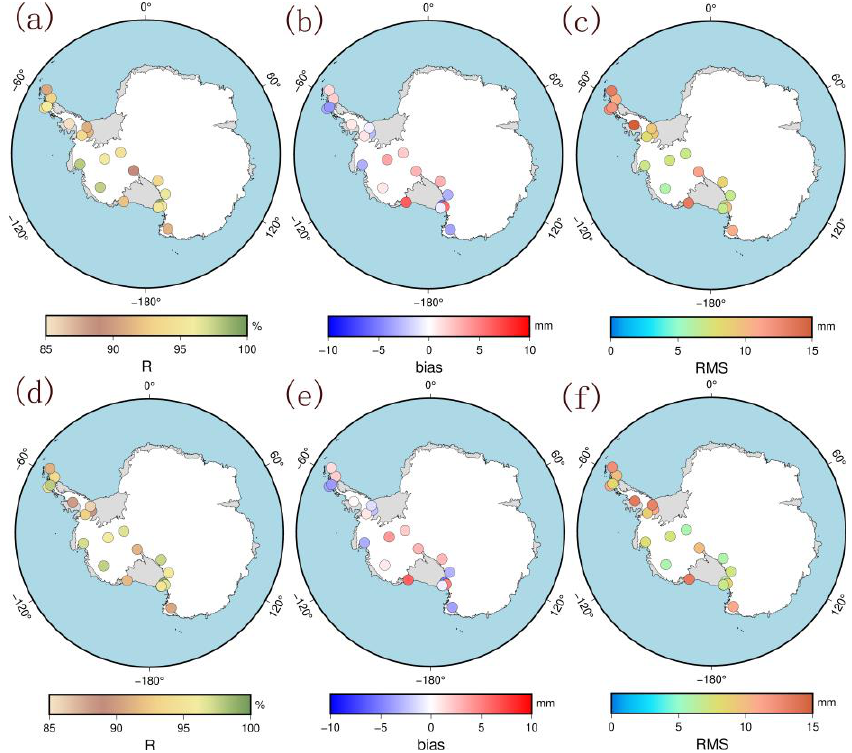
Figure 10. Distribution of correlation coefficient R, bias, and RMS between the ZTD models and GPS-ZTD of nonmodeling stations (( a ), ( b ) and ( c ) are the result of PCA; ( d ), ( e ) and ( f ) are the result of